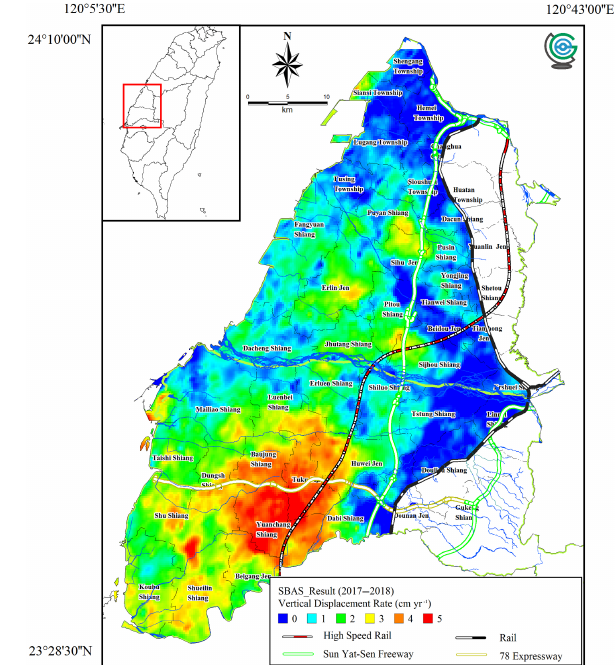
Figure 11. Vertical displacement rate from SBAS over 2017–2018.